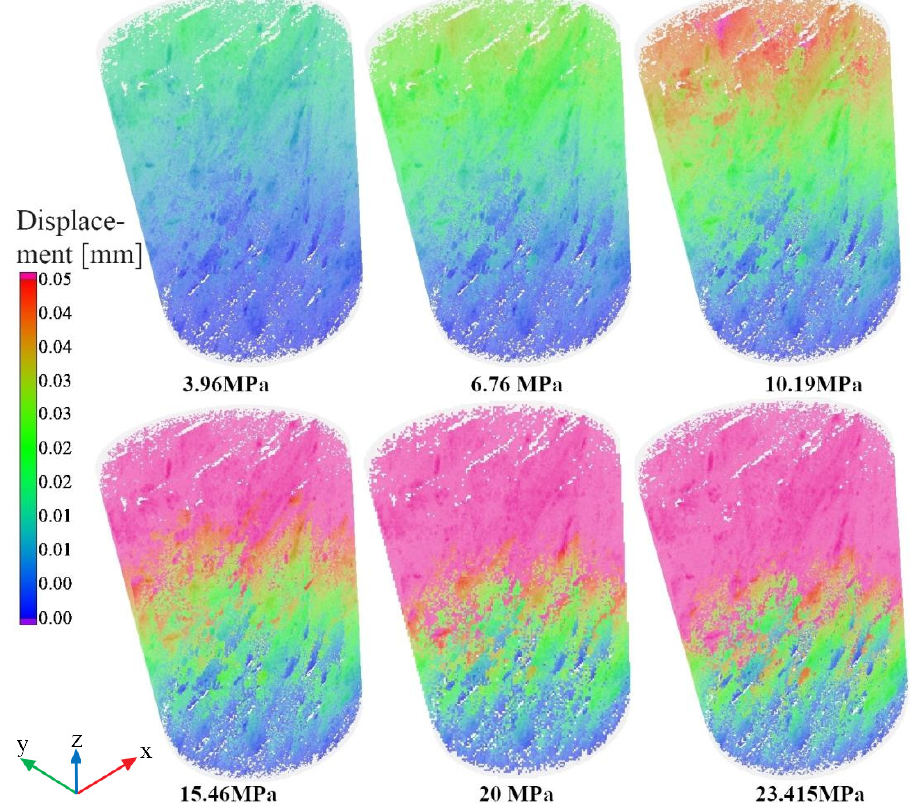
Figure 15. Simulated 3D maximum principal stress field under different loads.